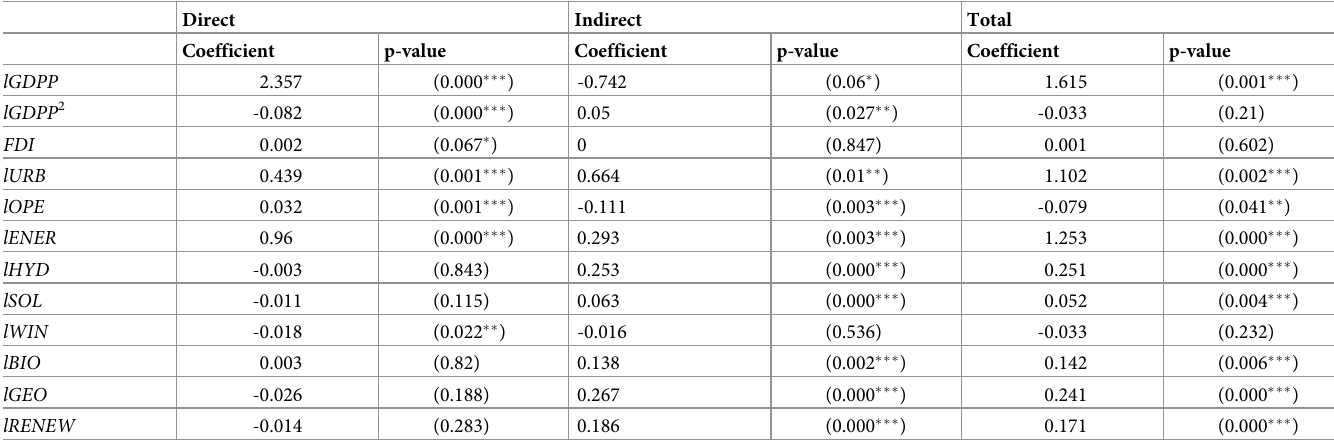
Table 7. Marginal effects of the CO 2 emission